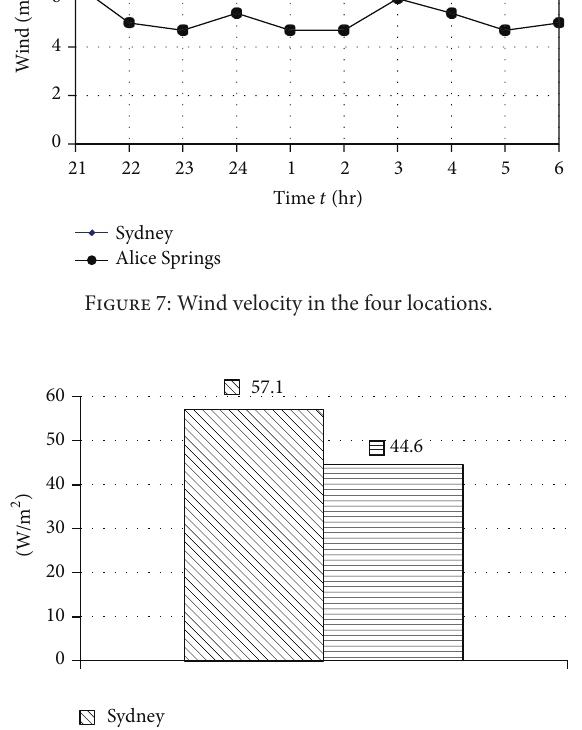
Figure 8: Net sky radiation in two different geographical